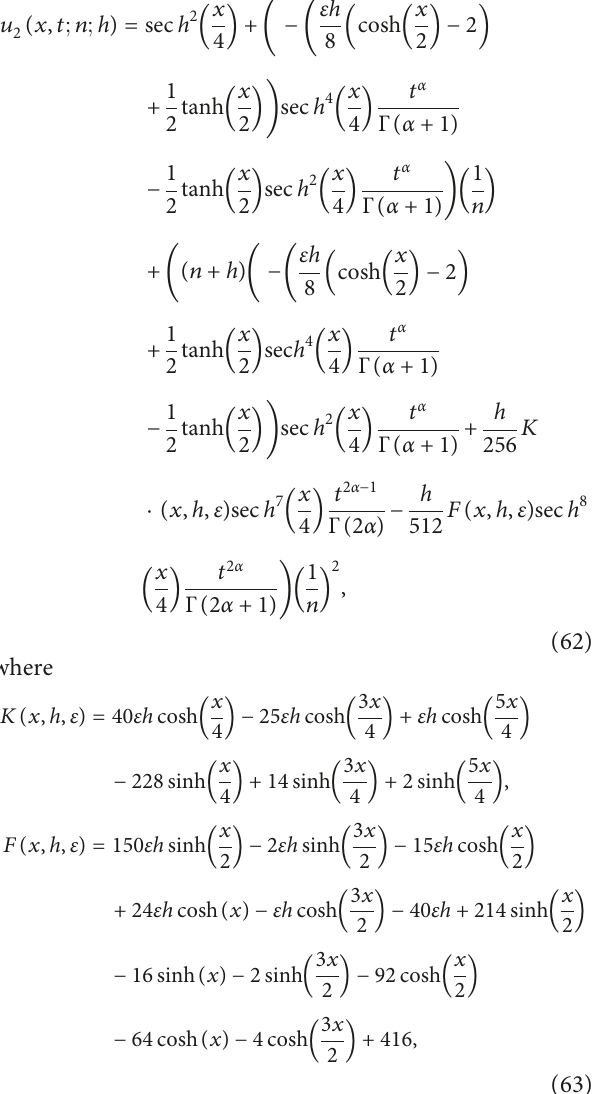
. (b) 􏽥 u ( x,t ) exact LSRPSM